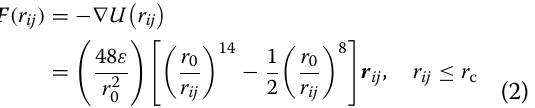
Table 1 The reduced units and SI units of the L-J potential and EAM potential Parameters L-J potential EAM potential Reduced units SI units Reduced units SI